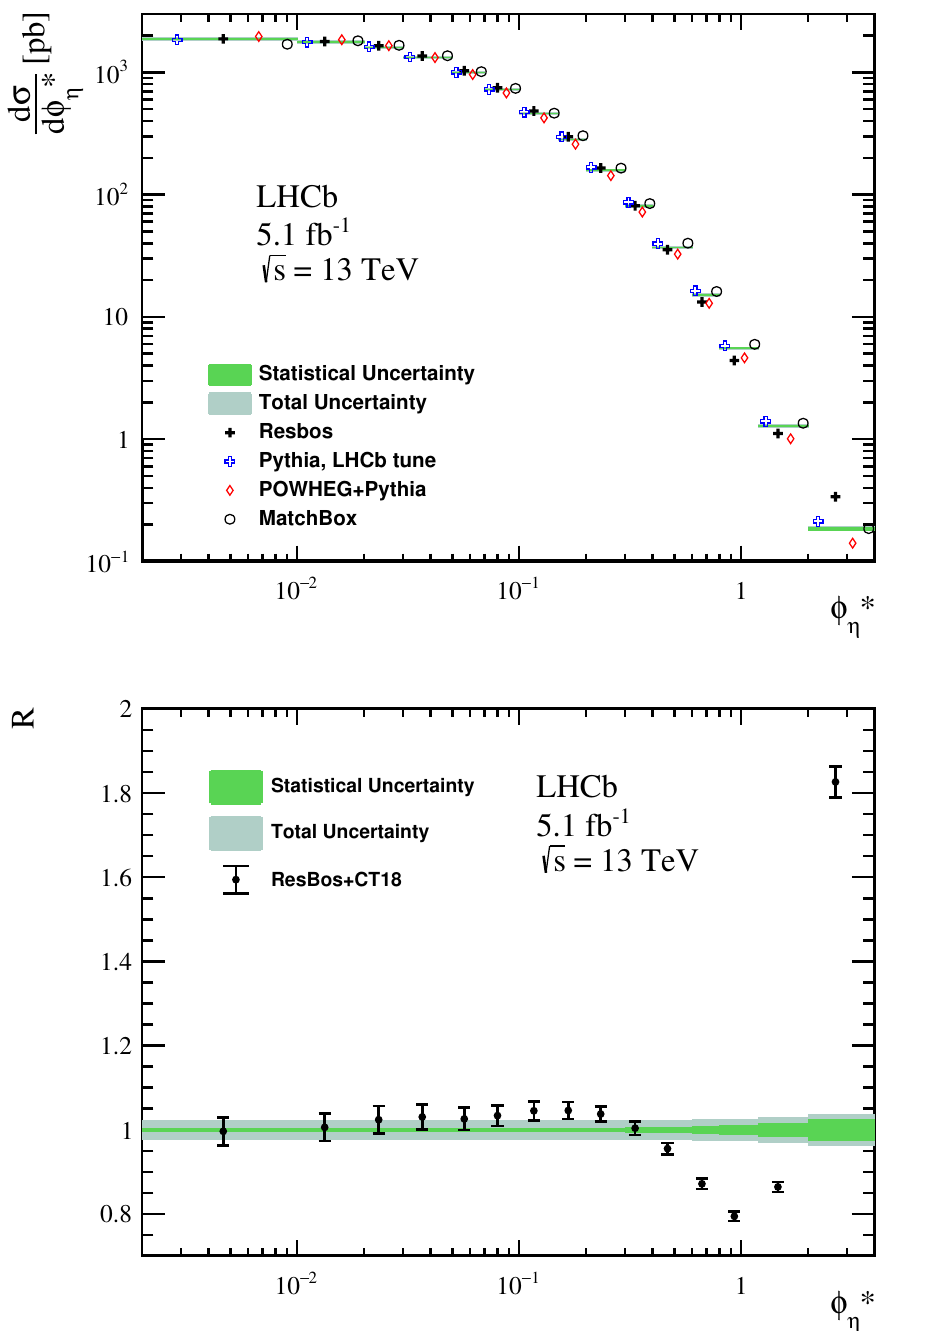
Figure 5 . (Top) Measured single differential cross-section in regions of φ ∗ theoretical predictions. (Bottom) Ratio of ResBos predictions to measurement, with the horizontal bars showing the uncertainty from the